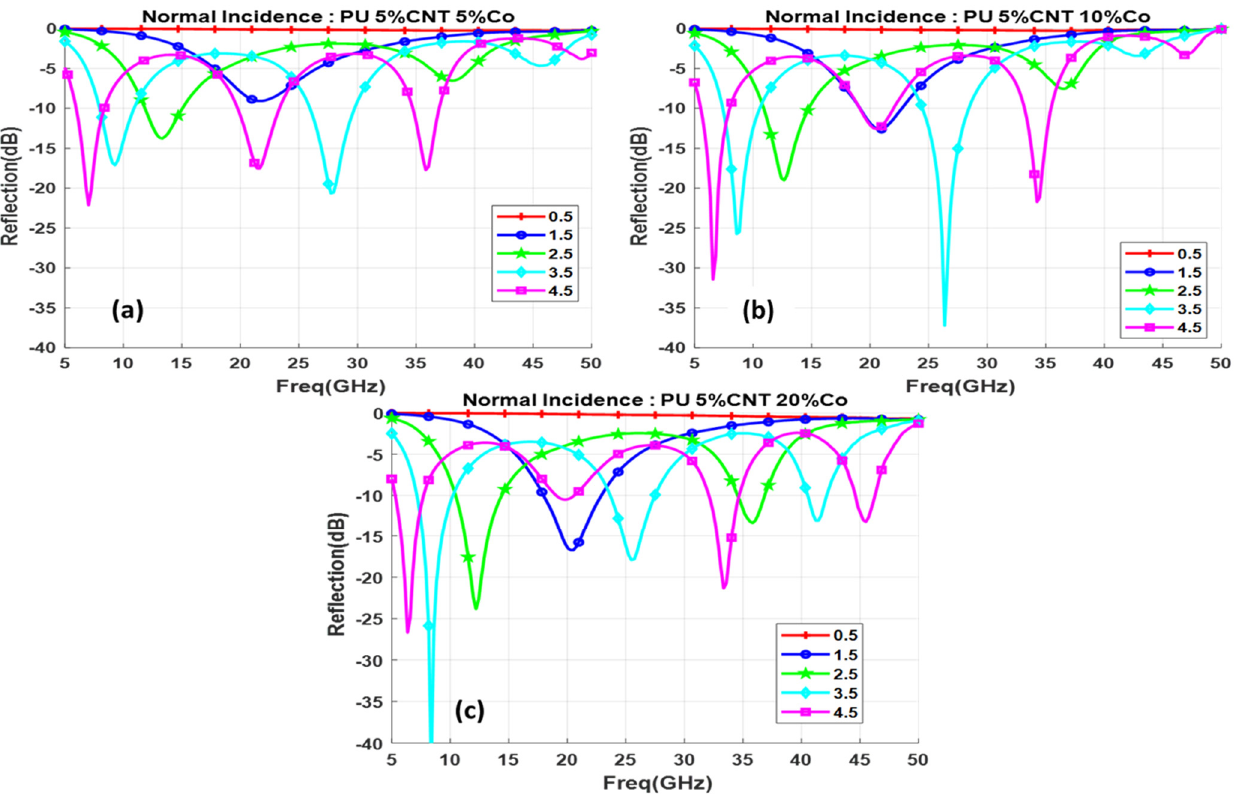
Figure 12. Reflection loss for functionalized composite with different thicknesses (d mm) for ( a ) 5% Co, ( b ) 10% Co, ( c ) 20% Co.